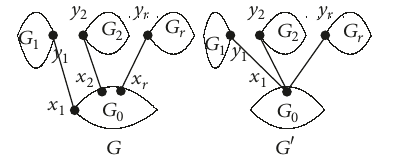
Figure 1: The graphs in Lemma